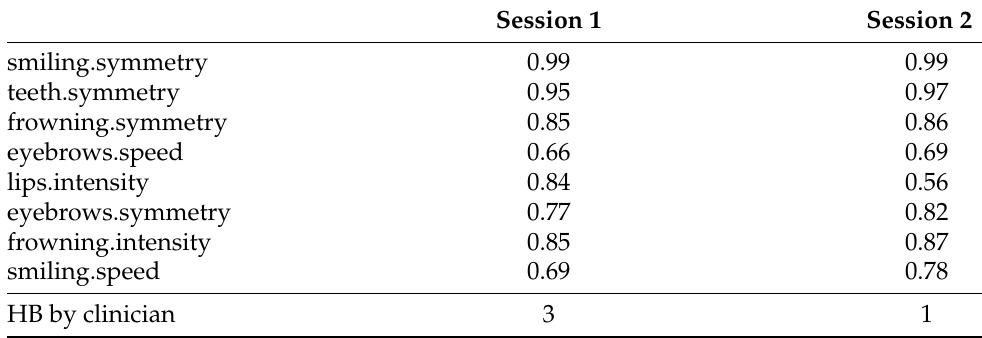
Table 14. Health scores of the misclassified patient.